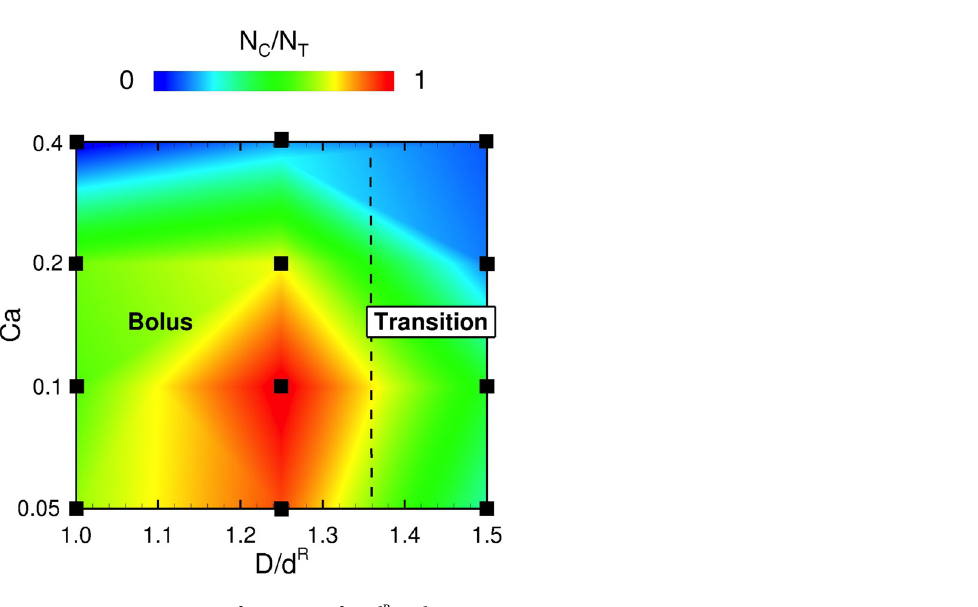
Figure 7. Capture ratio as functions of D / d R and Ca